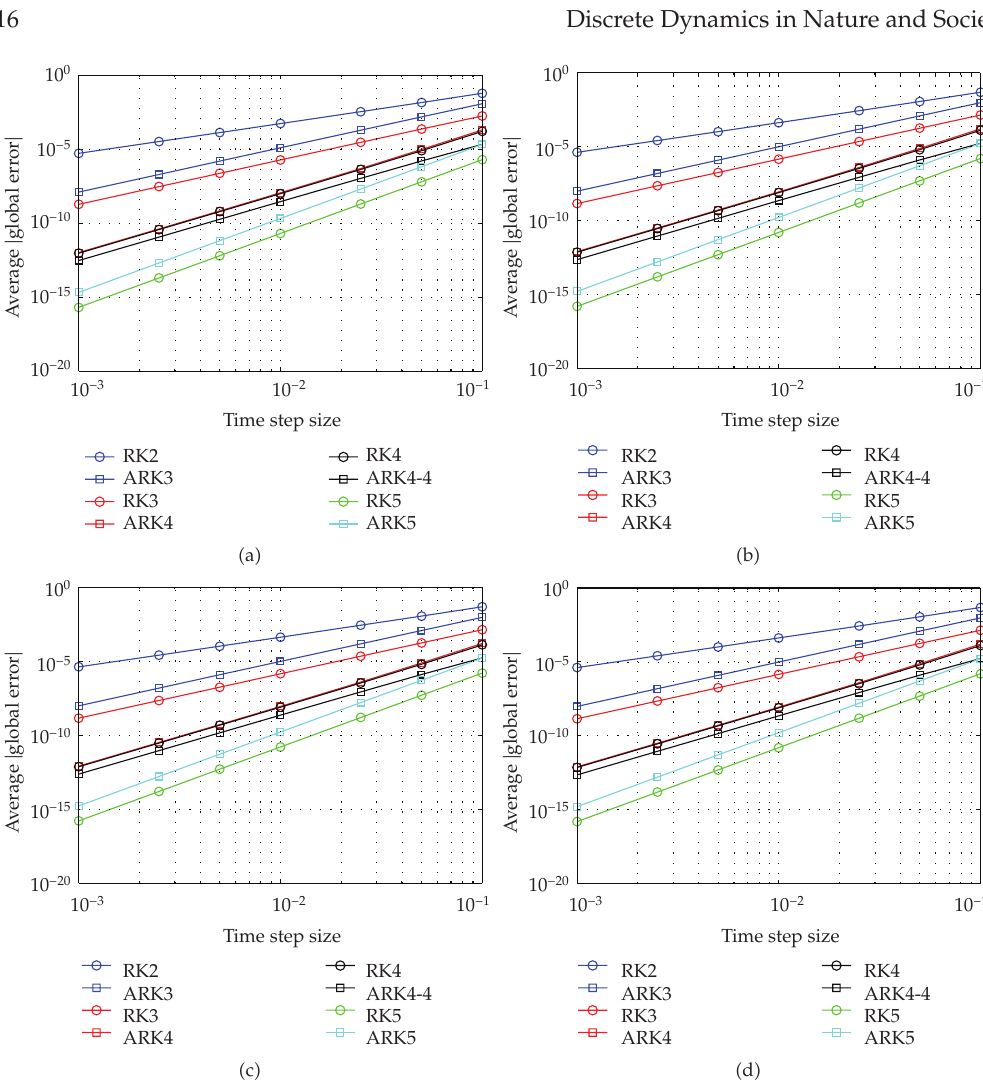
Figure 6: Accuracy plots for IVP-5: (cid:4) a (cid:5) y 1 , (cid:4) b (cid:5) y 2 , (cid:4) c (cid:5) y 3 , and (cid:4) d (cid:5) y 4 (cid:4) see caption of Figure 2 (cid:5)